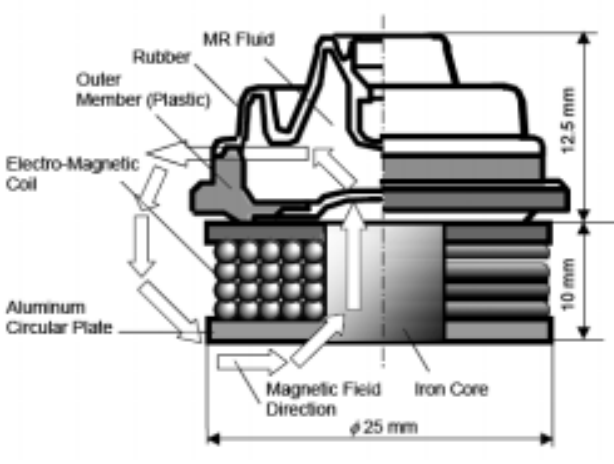
Fig. 2. Schematic view of a small size variable-damping mount using MR fluid